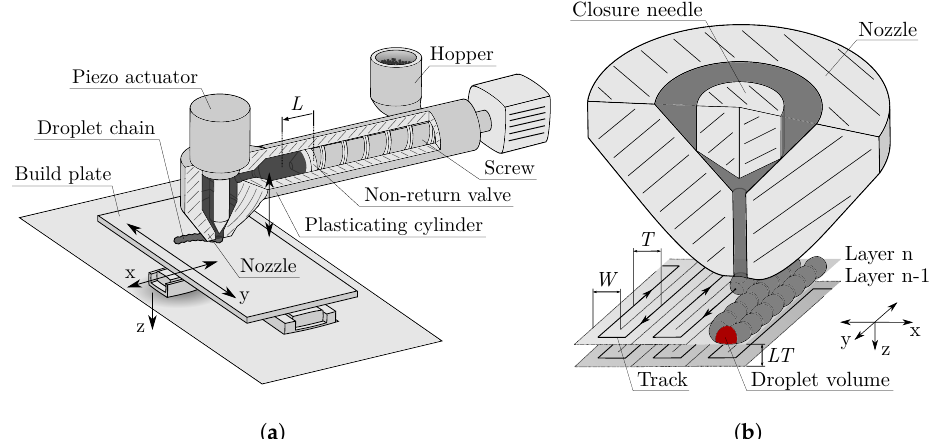
Figure 1. Visualisation of the APF process. ( a ): The most important components of the Arburg freeformer are given in a sketch of the moveable build plate with the three axes, the plasticating cylinder, and the closable nozzle. ( b ): Visualisation of important parameters that have an influence on the volume-filling of a layer. For simplicity, the orientation of the tracks is 0°